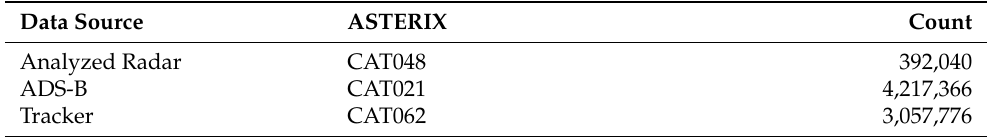
Table 5. Data source usage in